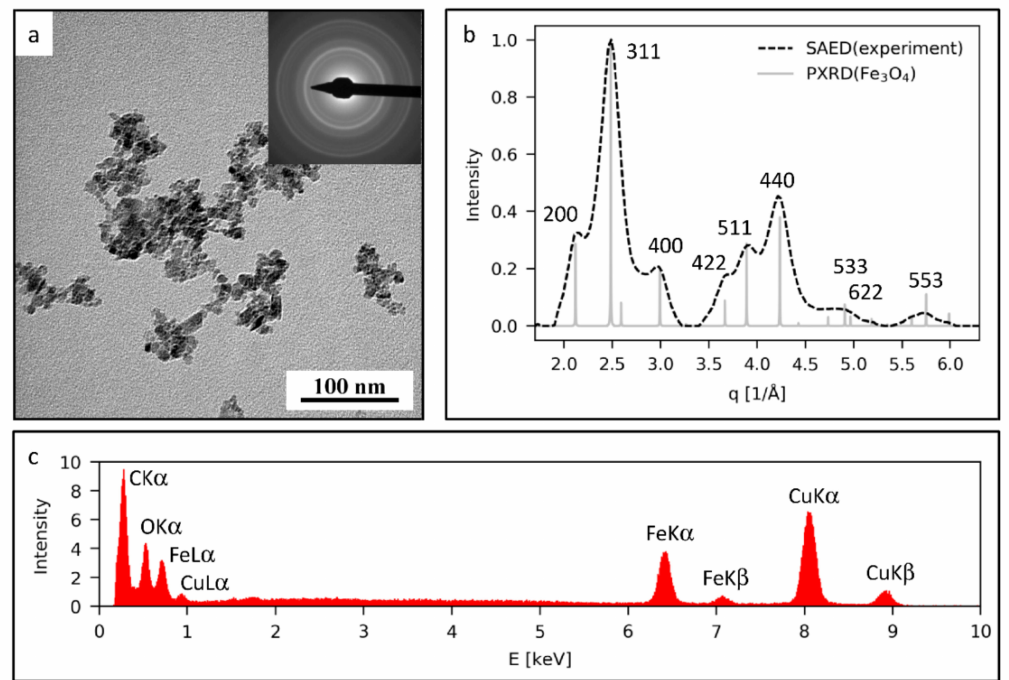
Figure 6. Transmission electron microscopy (TEM) analysis of the prepared magnetic nanoparticles (MNps): ( a ) TEM micrograph with corresponding selected area electron di ff raction pattern (TEM / SAED) di ff raction pattern, ( b ) comparison of the experimental TEM / SAED di ff raction pattern with the theoretically calculated di ff raction pattern of magnetite and ( c ) the energy dispersive X-ray analysis (TEM / EDX) spectrum of the